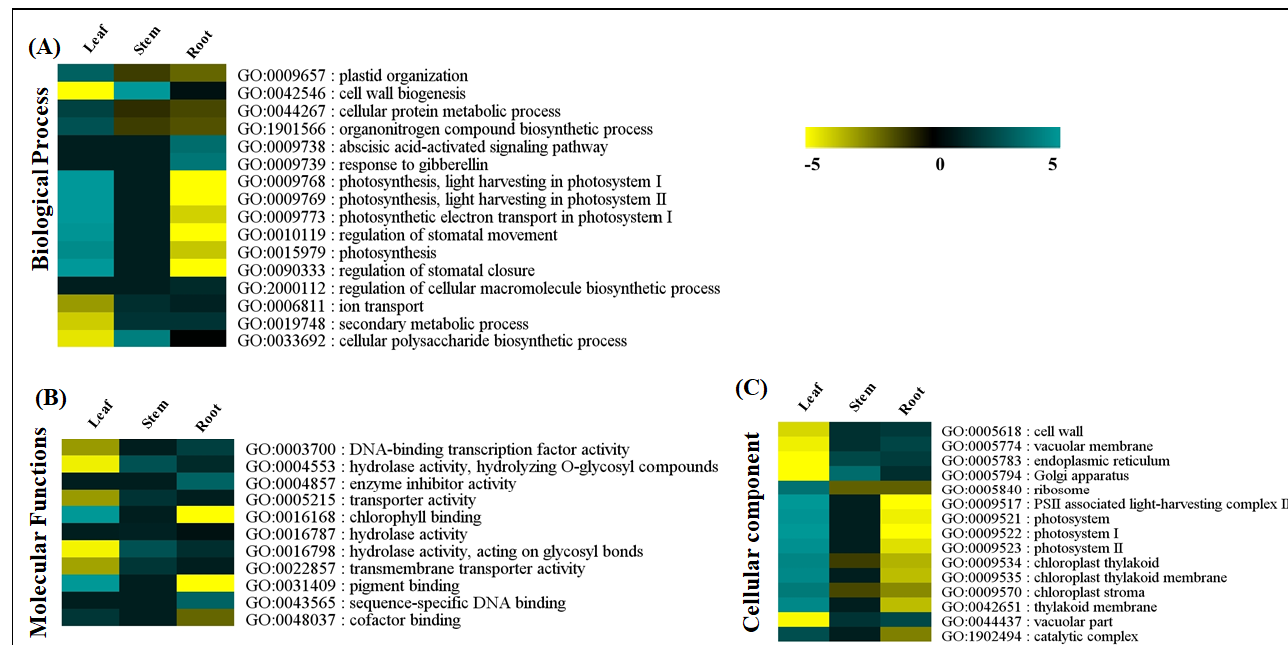
Figure 3. Heatmap representing GO enrichment classified into three categories: ( A ) biological processes; ( B ) molecular functions; ( C ) cellular components, in leaf, stem, and root tissues of A. glauca .